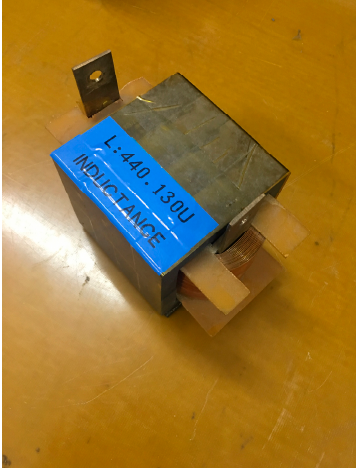
Figure 15. Front-end three-level buck converter inductor filter.